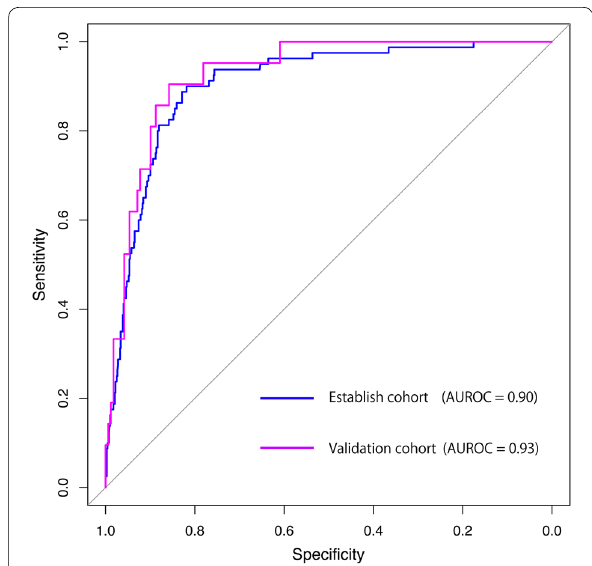
Fig. 2 Receiver operating curves of the risk adjustment model in the establishment and validation cohort. AUROC area under the receiver operating curve